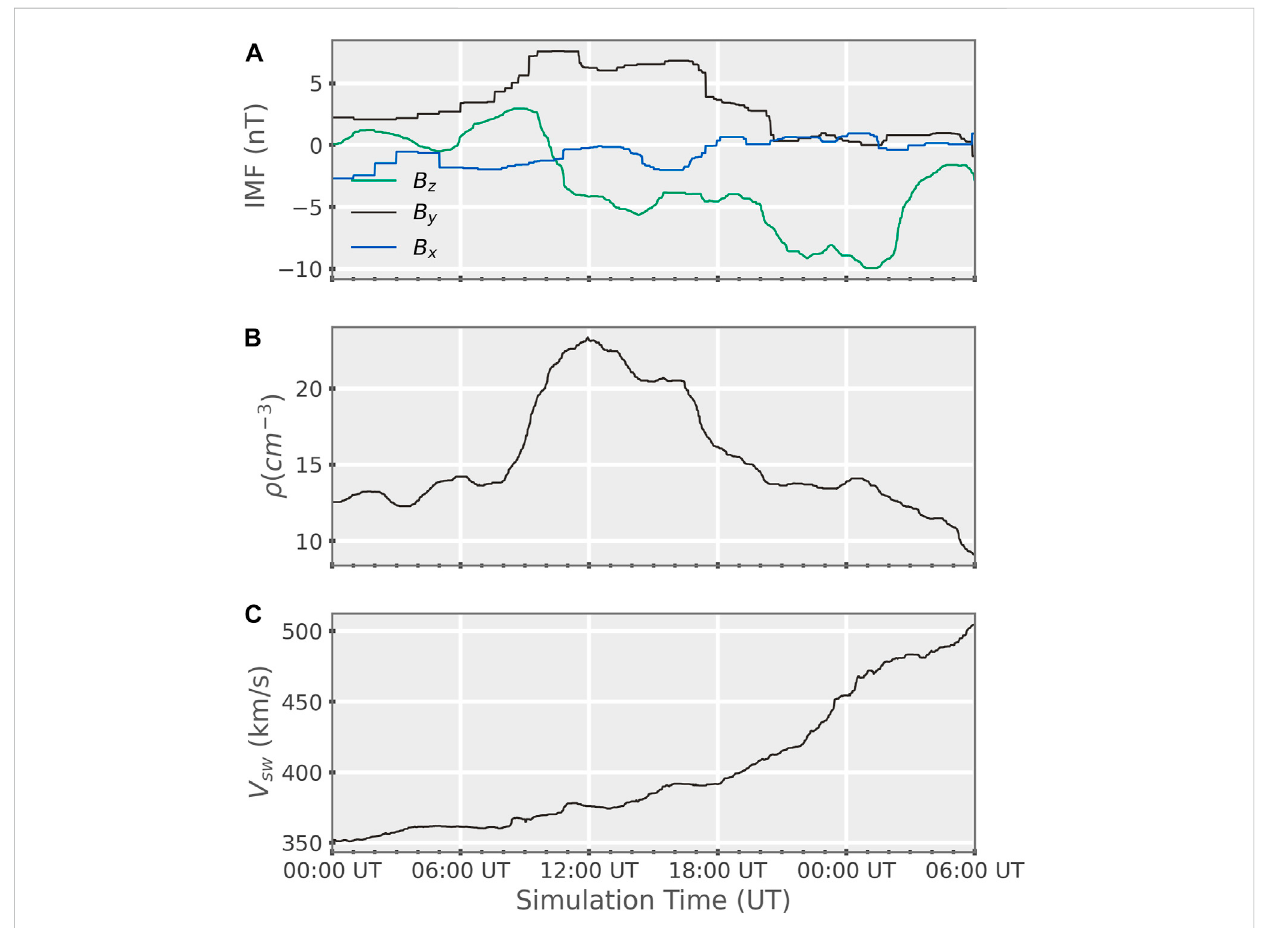
FIGURE 9 (A) Magnitude of disturbance from quiet time average of the B z and B y components of the IMF. (B) Density of the solar wind as a function of simulation time. (C) Velocity of solar wind as a function of simulation